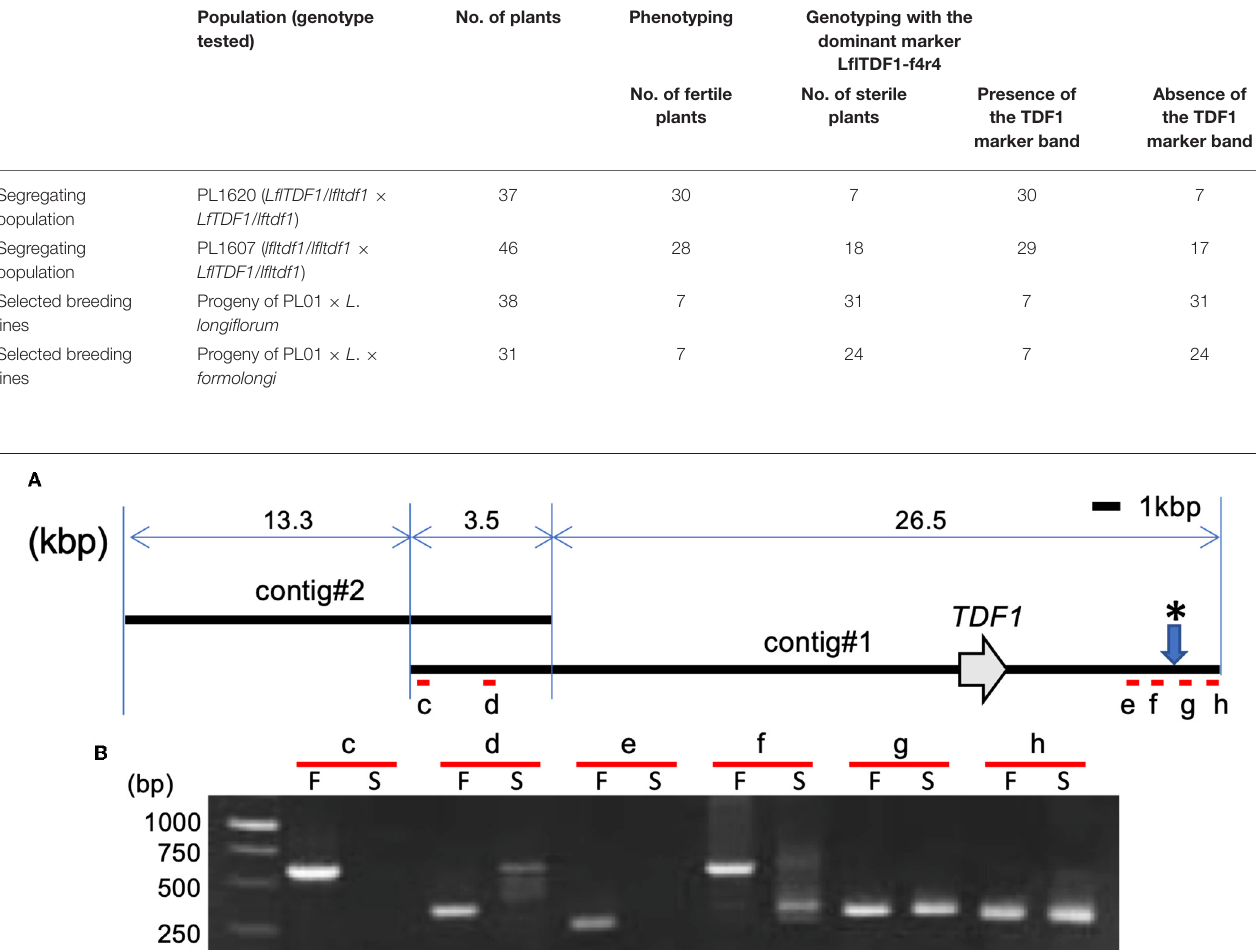
TABLE 4 | Phenotyping and genotyping in the segregating populations and the selected breeding lines.